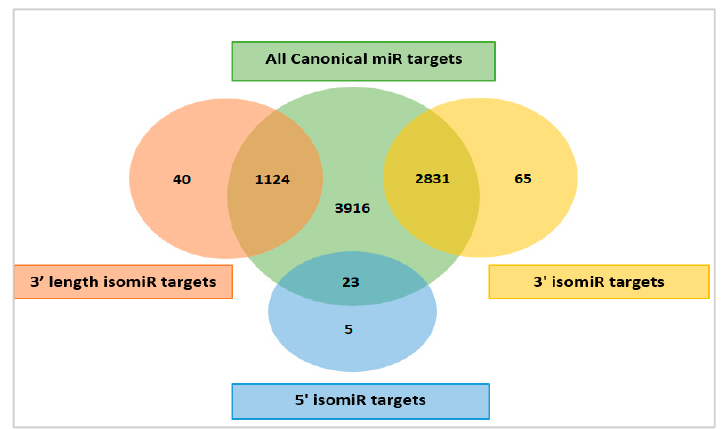
Figure 3. A Venn diagram depicting the overlap and difference between the predicted target genes of canonical miRNAs (green color), 3’ isomiRs (yellow color), 3’ length isomiRs (red color), and 5’ isomiRs (blue color).